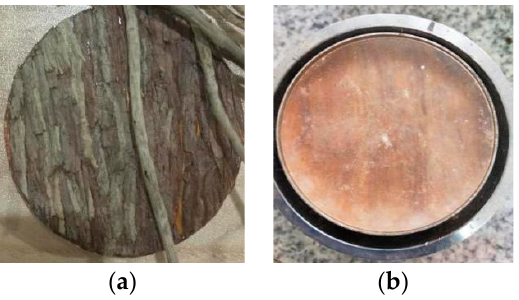
Figure 9. Schematic diagram of shear resistance test at root–soil interface.